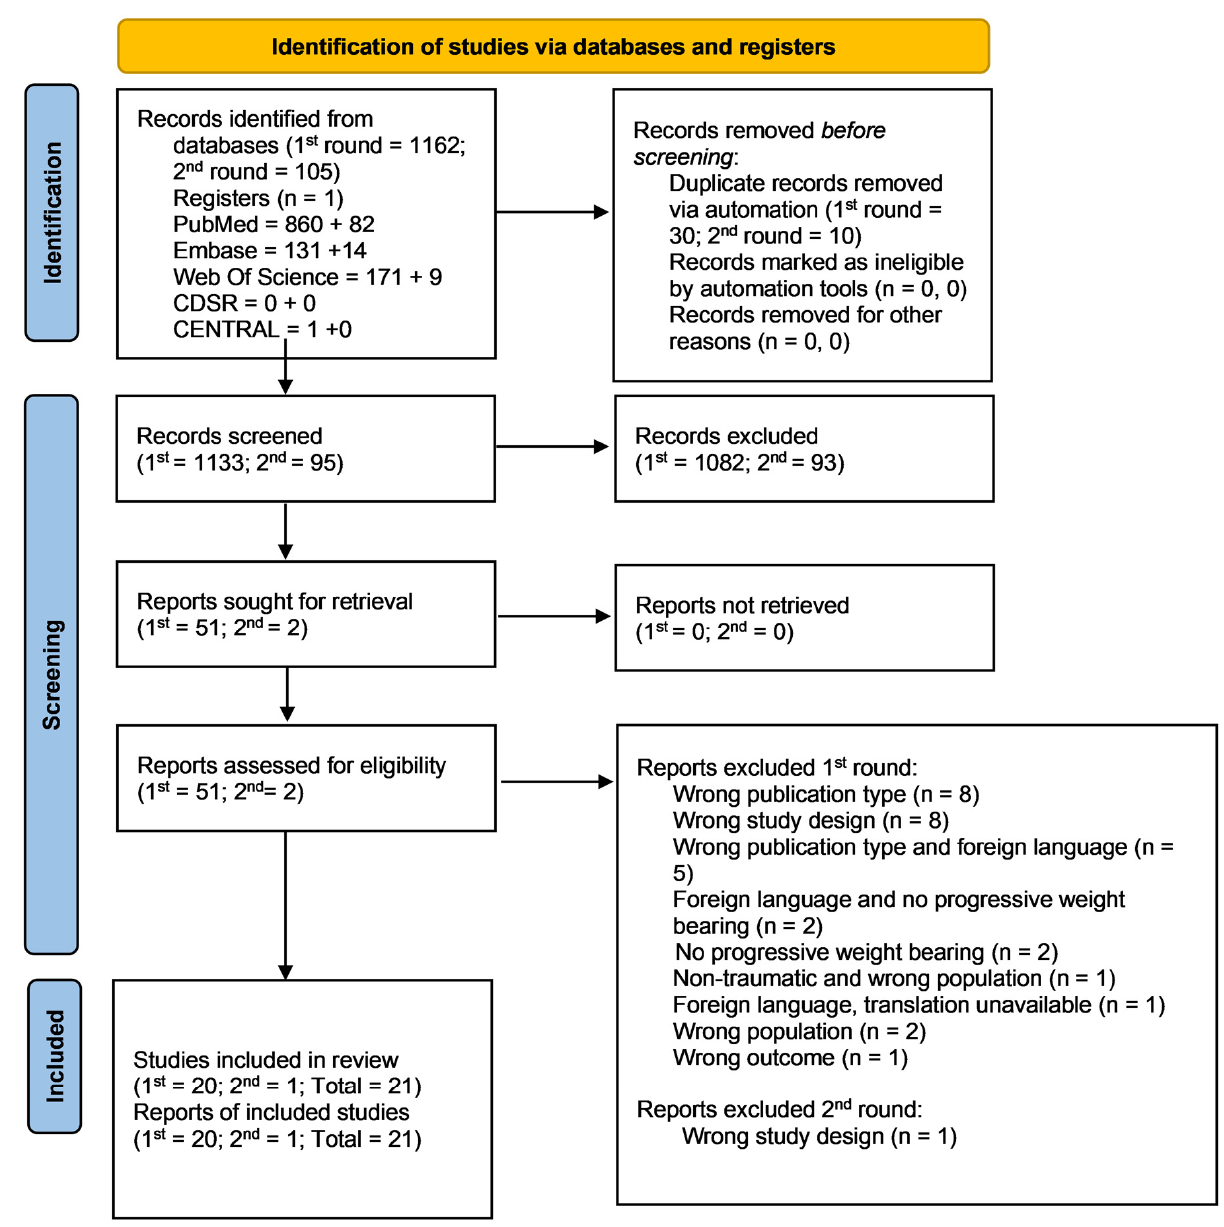
Figure 1. PRISMA